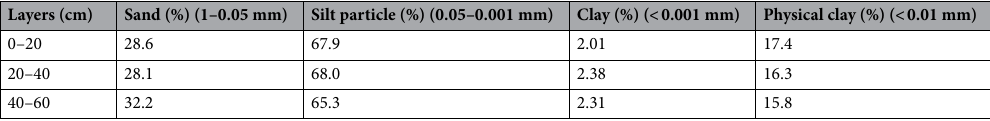
Table 1. Soil particle composition.